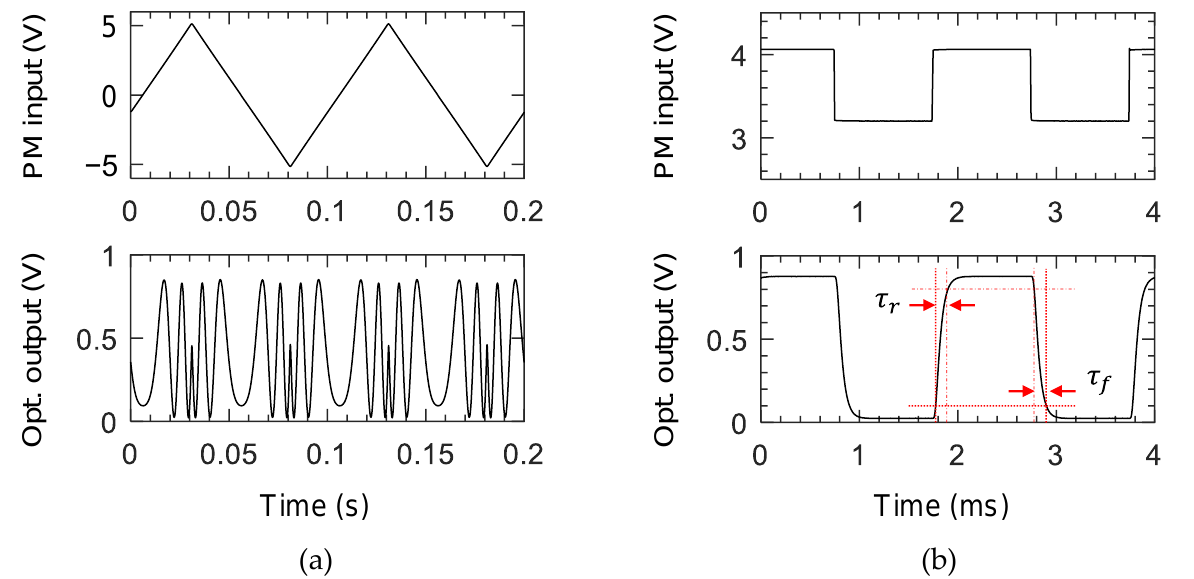
Figure 6. Intensity-modulated signal from Mach–Zehnder interferometer (MZI). ( a ) MZI output signal as a function of 10 Hz triangular signal input to induce a phase modulation over 4 π , and ( b ) MZI output signal for a 500 Hz square wave input signal when the voltage levels were adjusted to obtain the best extinction ratio.